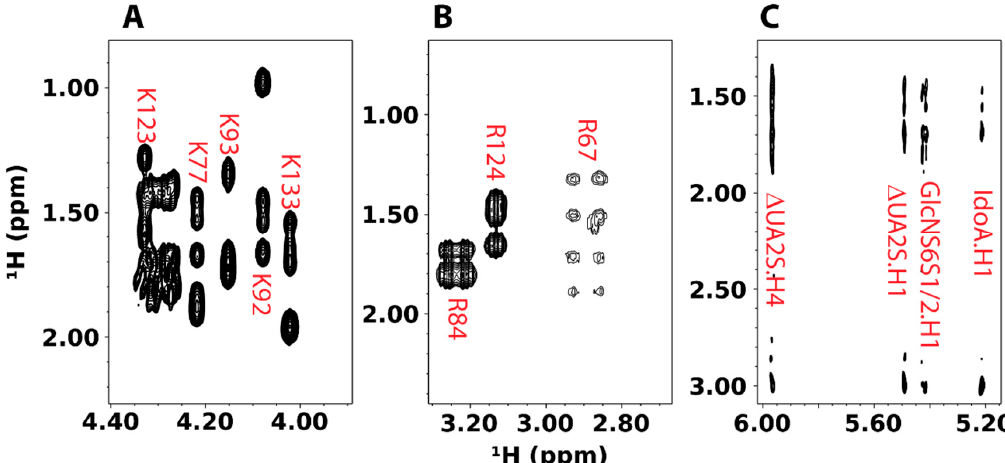
Figure 14. 2D homonuclear NOESY spectra of deuterated pleiotrophin containing either 1 H-labeled lysine or arginine. ( A ) H α region of the NOESY spectrum of 2 H-pleiotrohpin with specific 1 H lysine labeling. Signals from lysines in the structured regions of pleiorophin are labeled in red. ( B ) H δ region of the NOESY spectrum of 2 H-pleiotrohpin with specific 1 H arginine labeling. Signals from assigned arginines are labeled in red. ( C ) NOESY cross-peaks arising from intermolecular contacts involving GAG anomericprotons of 0.2 mM 2 H-pleiotrophin with 1 H lysine labeling in the presence of 2 mM heparin tetrasaccharide, Δ UA2S-GlcNS6S-IdoA2S-GlcNS6S.